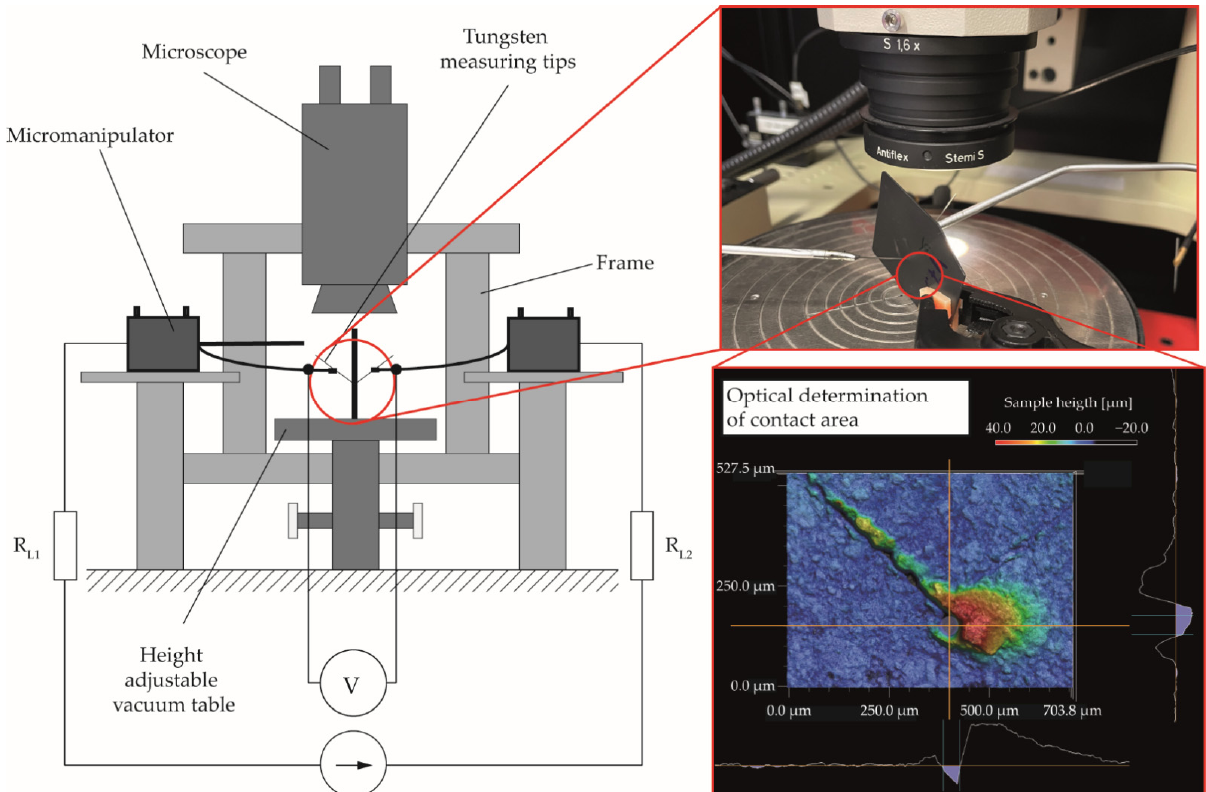
Figure 3. Schematic illustration of the measurement of the electrical resistance of the manufactured plate specimens.